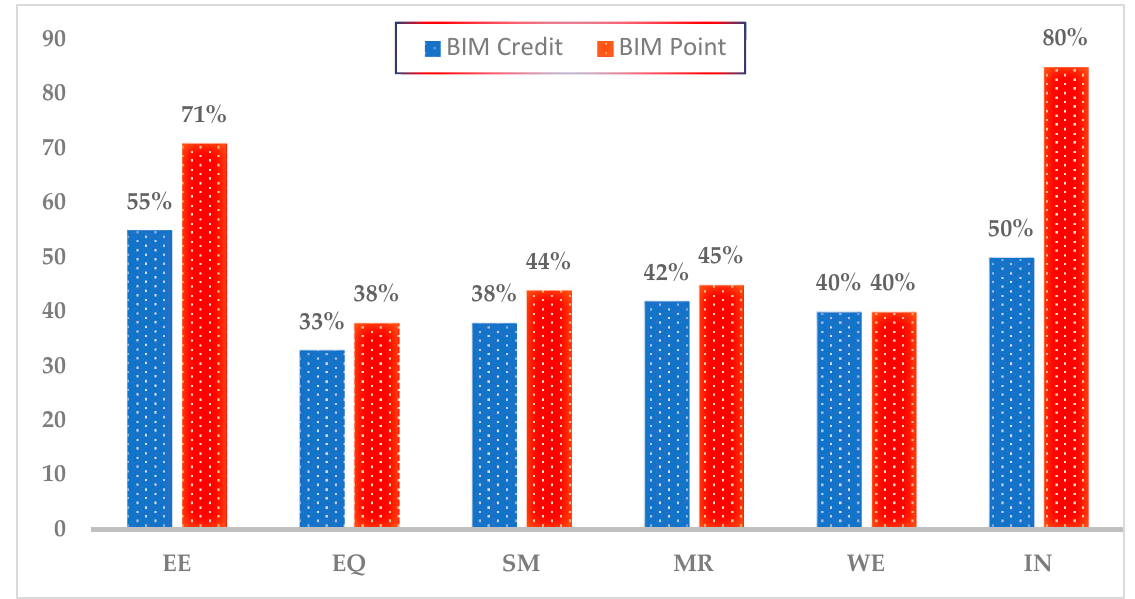
Figure 5. BIM–GBI Assessment in DA.